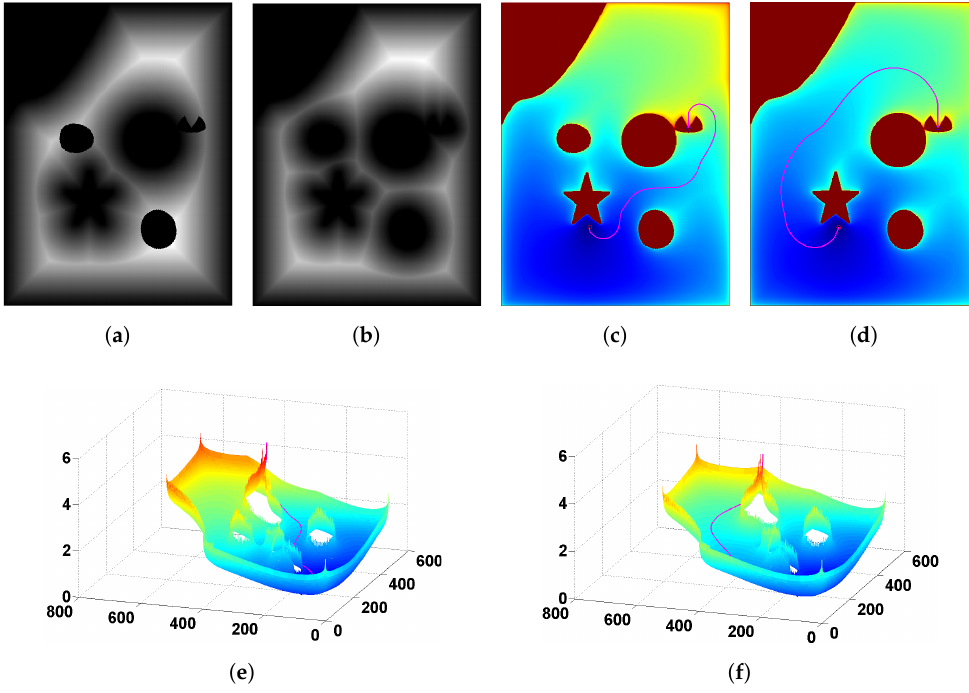
Figure 15. The process of path re-planning. ( a ) Addition of domain models to potential map V (time 0.08 s); ( b ) New potential map V (cid:48) by tunable fast marching square (TFMS; time 0.20 s); ( c ) Generated path and arrival time matrix T (time 0.22 s); ( d ) Generated path and arrival time matrix T with a single target vessel domain model; ( e ) Generated path and arrival time matrix T in three dimensions; ( f ) Single target vehicle domain model in three dimensions.